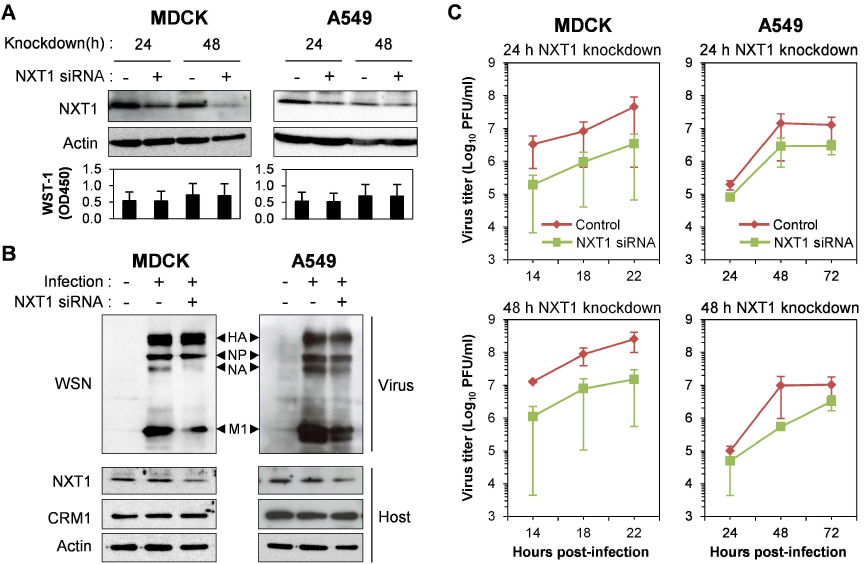
Figure 2. NXT1 knockdown reduces viral replication kinetics. ( A ) Madin-Darby canine kidney (MDCK) or A549 cells were transfected with control or NXT1 siRNA for 24 or 48 h. The cells were subjected to WB analysis with anti-NXT1 and anti- β -actin antibodies (upper panel) or water-soluble tetrazolium (WST-1) assay (lower panel). Data shown are the results from two independent experiments and the mean values. ( B ) MDCK or A549 cells were transfected with control or NXT1 siRNA for 24 h and infected with influenza A/WSN/33 virus at a multiplicity of infection (MOI) = 0.0001 for 18 h and 48 h, respectively. The cells were then collected, lysed, and subjected to WB analysis with anti-WSN, anti-NXT1, anti-CRM1, and anti- β -actin antibodies. ( C ) MDCK or A549 cells were transfected with control or NXT1 siRNA for 24 h or 48 h, and infected with influenza A/WSN/33 virus at MOI = 0.0001. Supernatants were collected at 14, 18, and 22 h post-infection (hpi) from MDCK cells, or at 24, 48, and 72 hpi from A549 cells for virus titration by plaque assay. Viral replication kinetics were plotted for virus titer and time post-infection. Data shown are the results from two independent experiments (error bars) and the mean